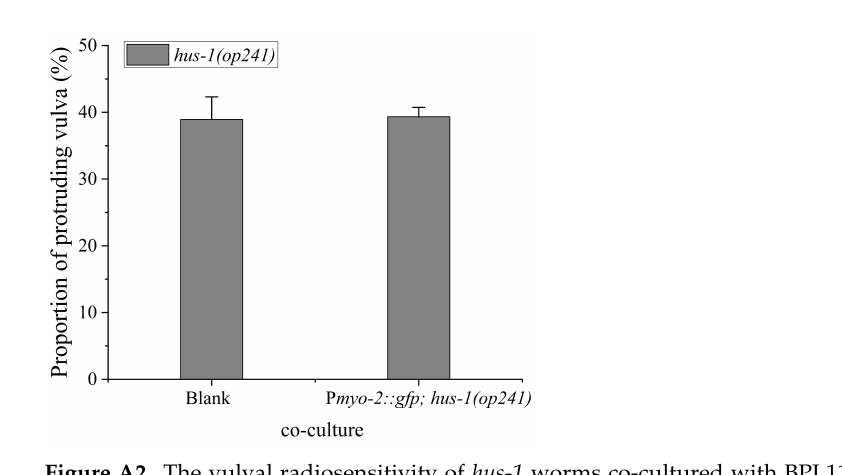
Figure A1. Vulval radiosensitivity of the worm lines BPL1122 and BPL1123 [P myo-2::gfp::hus-1; hus-1(op241) ] ( A ), BPL1111: P myo-2::gfp::hus-1; N2 ( B ), BPL1100: P myo-2::gfp; N2 ( C ), and BPL1101: P myo-2::gfp; hus-1(op241) ( D ). Results are means ± SD ( n ≥ 3, t -test, ** p < 0.01).